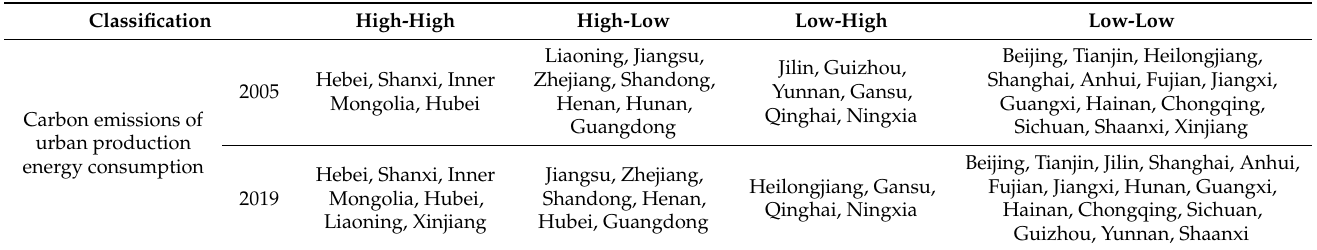
Table 5. Carbon emission classification from urban production energy